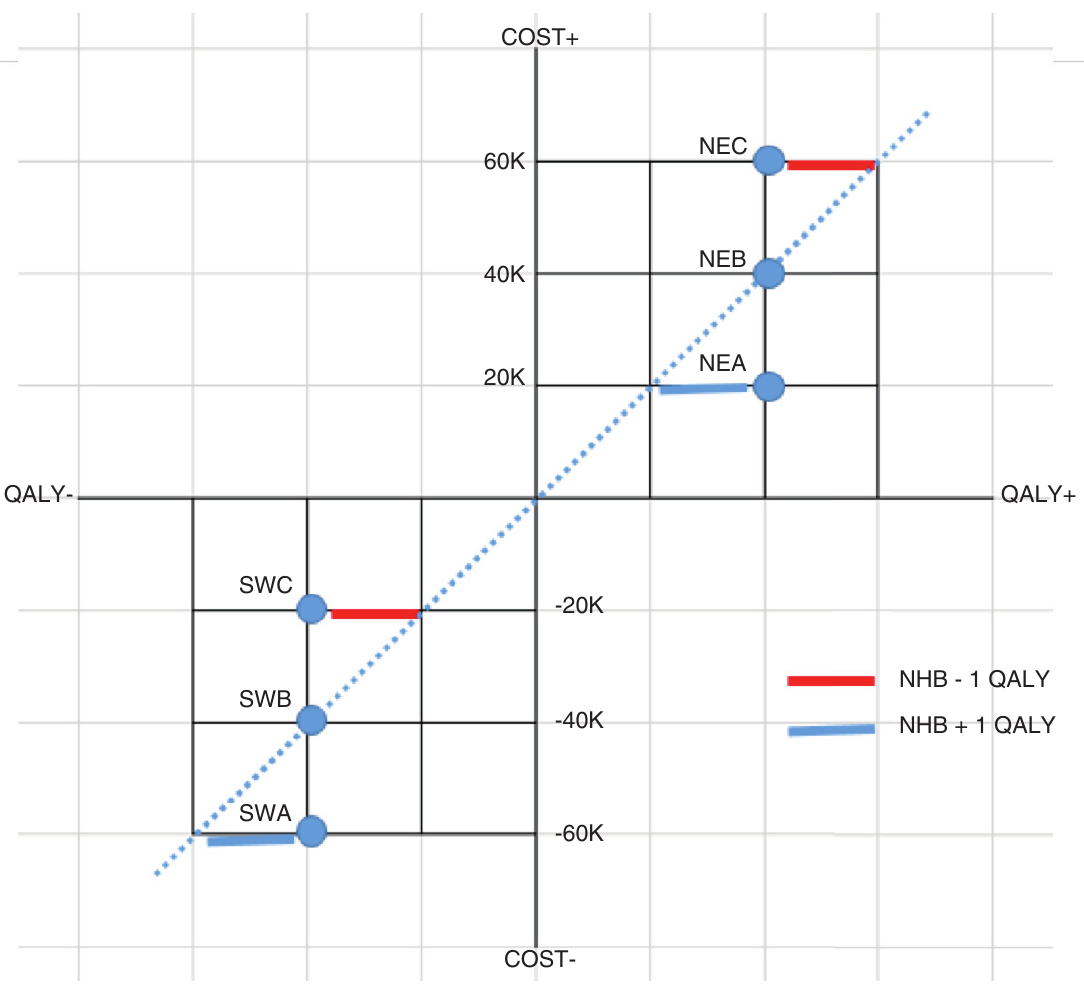
Figure 1. Full cost-effectiveness plane based on Claxton’s figure 1 confined to North-East